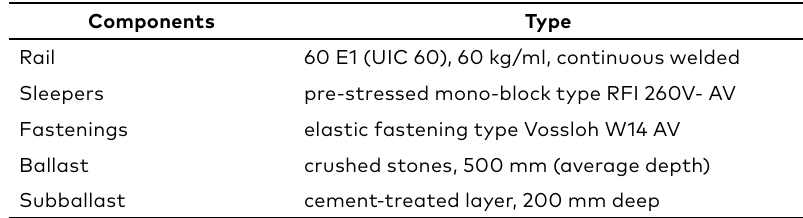
Table 3. Ballasted track